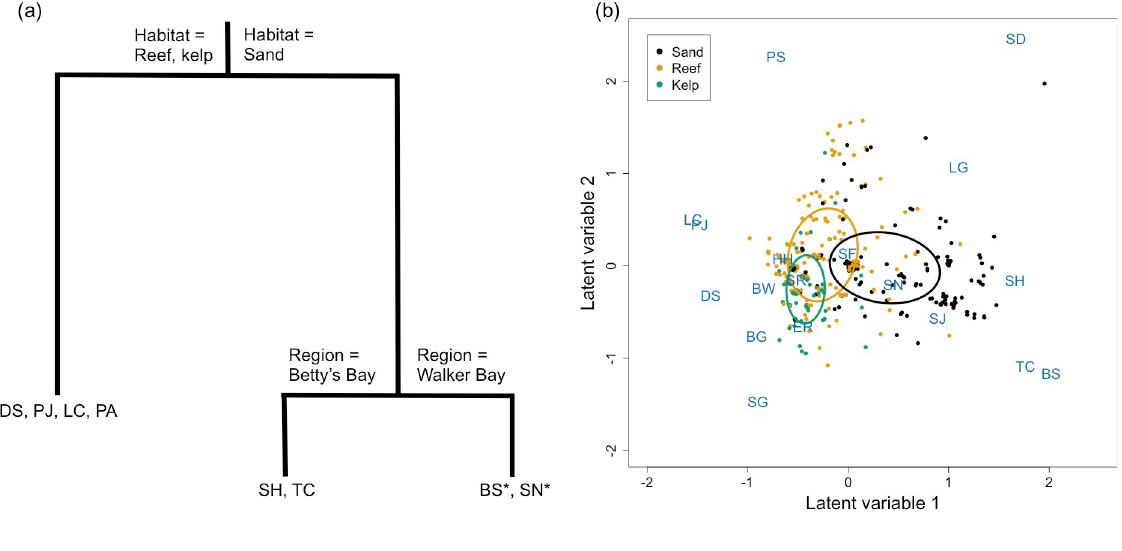
Fig 5. (a) Multivariate regression tree (MRT) and (b) boral latent variable ordination of the observed chondrichthyan community. Points are colour-coded by habitat. The ellipses represent 95% confidence intervals around the mean for sites from each habitat. Two-letter species’ codes (explained in Table 1) (a) represent the species with DLI values > 0.15 (except those marked with � , the most important species for that cluster: DLI0.08–0.12), and (b) are positioned to show the relative values for the coefficient for that species on each latent variable